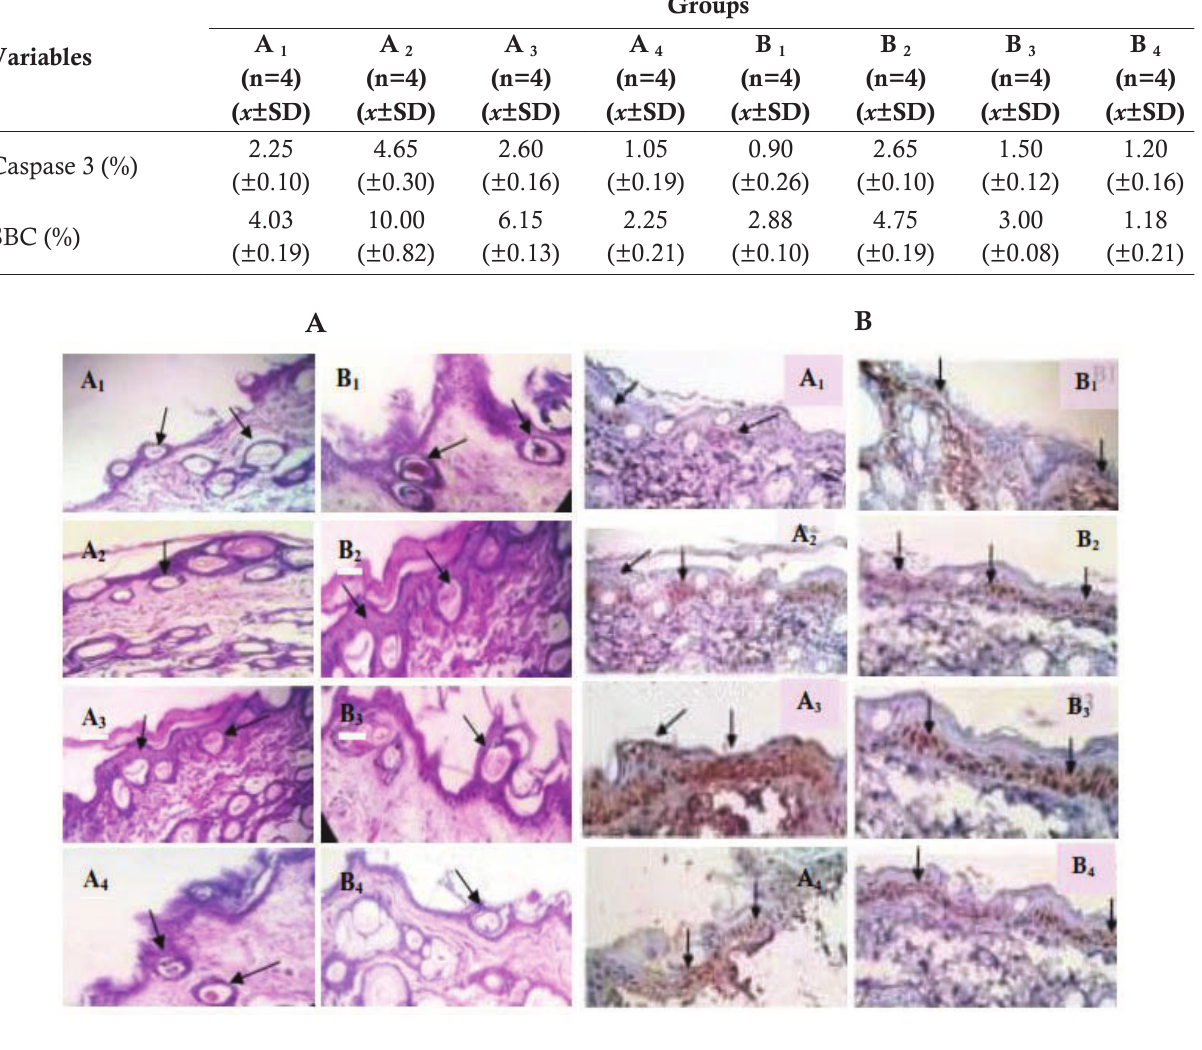
Figure 1. A. Hystophatological picture of sunburn cell was stained by Hematoxylin Eosin in each subgroups; B. Hystophatological picture of sunburn cell was stained by Immunohystochemistry in each subgroups following UVB irradiation